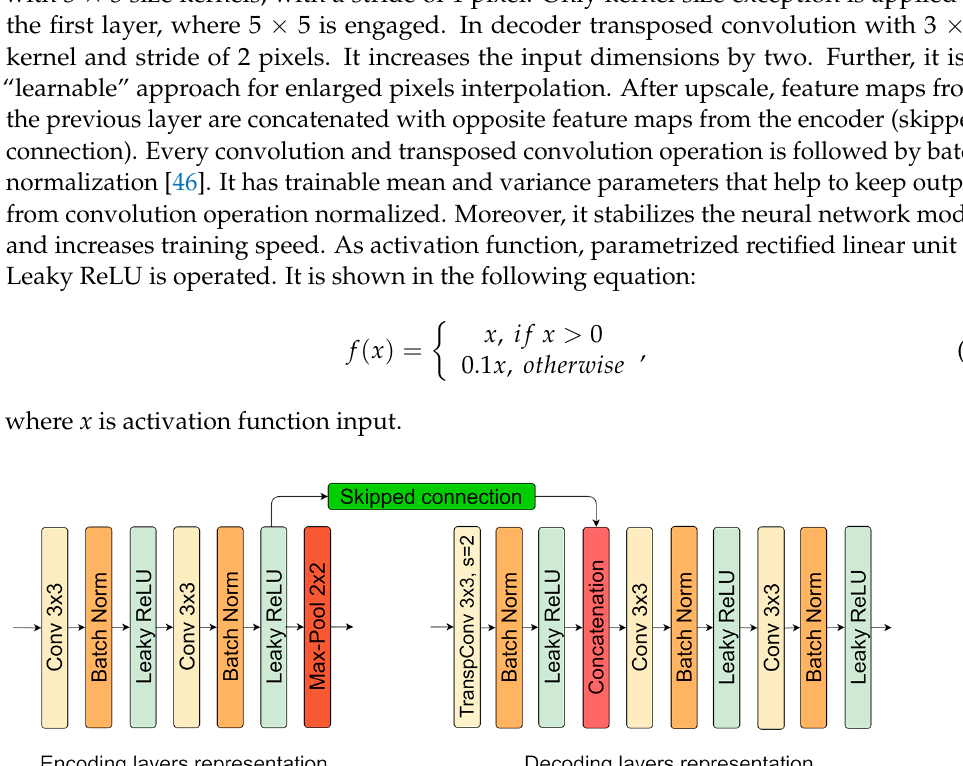
Figure 3. Residual layer representation.